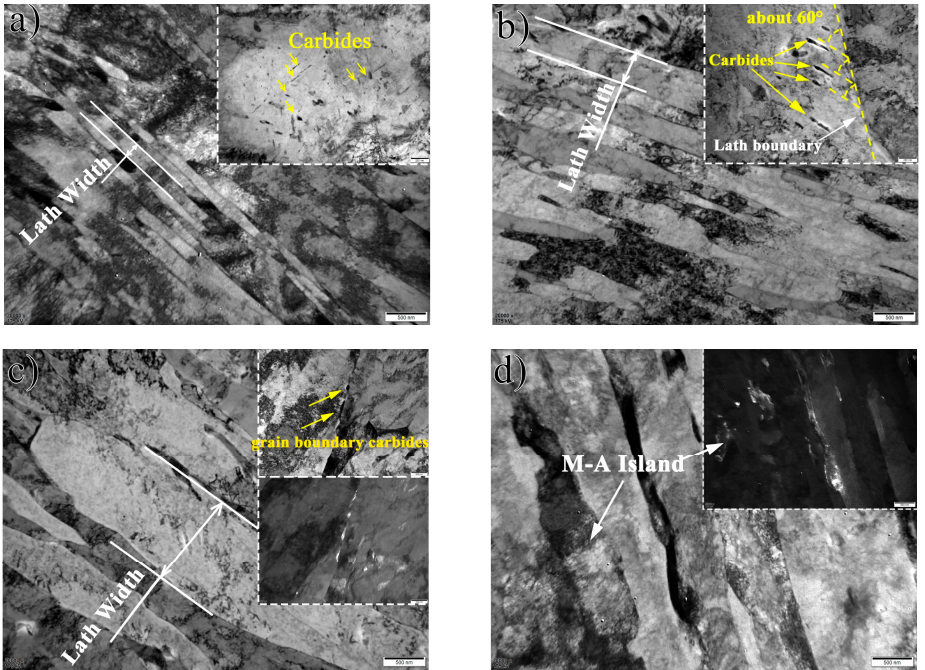
Figure 3. TEM presents the lath width and typical carbides distribution at different positions: ( a ) 10